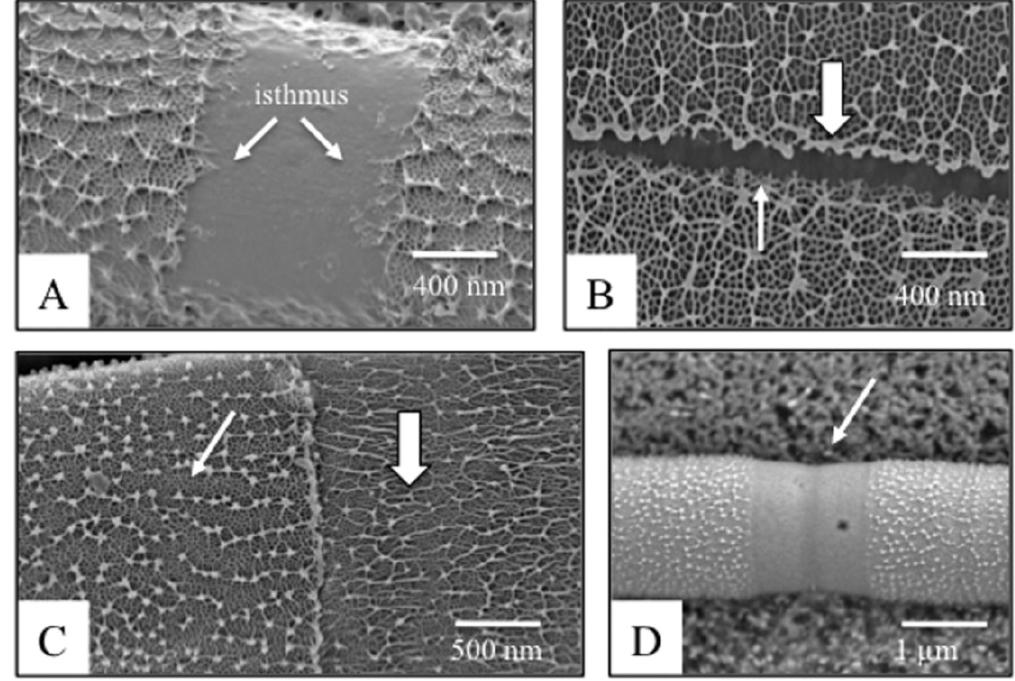
Figure 4. SEM imaging of the cell wall (see [25,27] for details). ( A ) FESEM image of the isthmus zone (“isthmus”, arrows). Note that the outer wall lattice projections are not present in the isthmus; ( B ) FESEM image of a lateral band. On the outer edge of the band ( i.e. , facing a pole of the cell), the projections are thick (large arrow). On the inner edge, the lattice is smaller (small arrow). No projections are found in the middle of the band; ( C ) FESEM image of a cell incubated for 48 h in medium supplemented with 10 × CaCl 2 . The older wall (small arrow) possesses the typical outer lattice. However, in the newer wall zone formed when under high Ca 2+ conditions, the lattice forms a series of elongated ridges (large arrow; see also [27]); ( D ) VPSEM image of a cell treated for 48 h with PME. Note that at